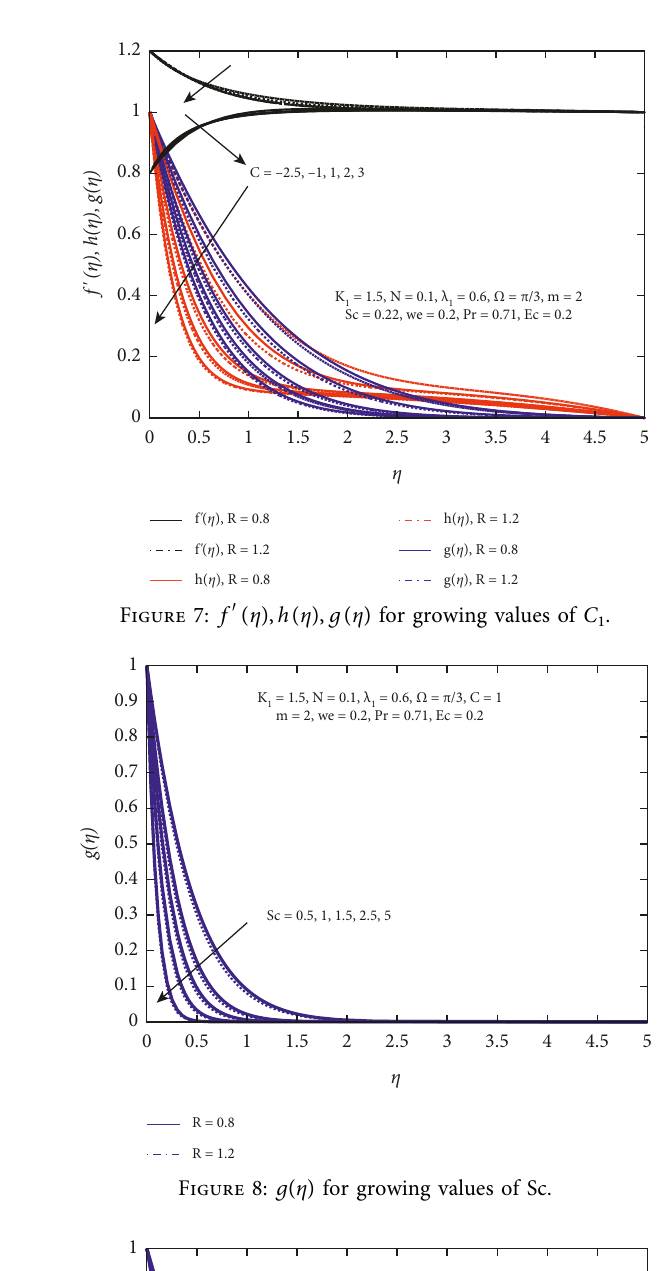
Figure 8: g ( η ) for growing values of Sc.